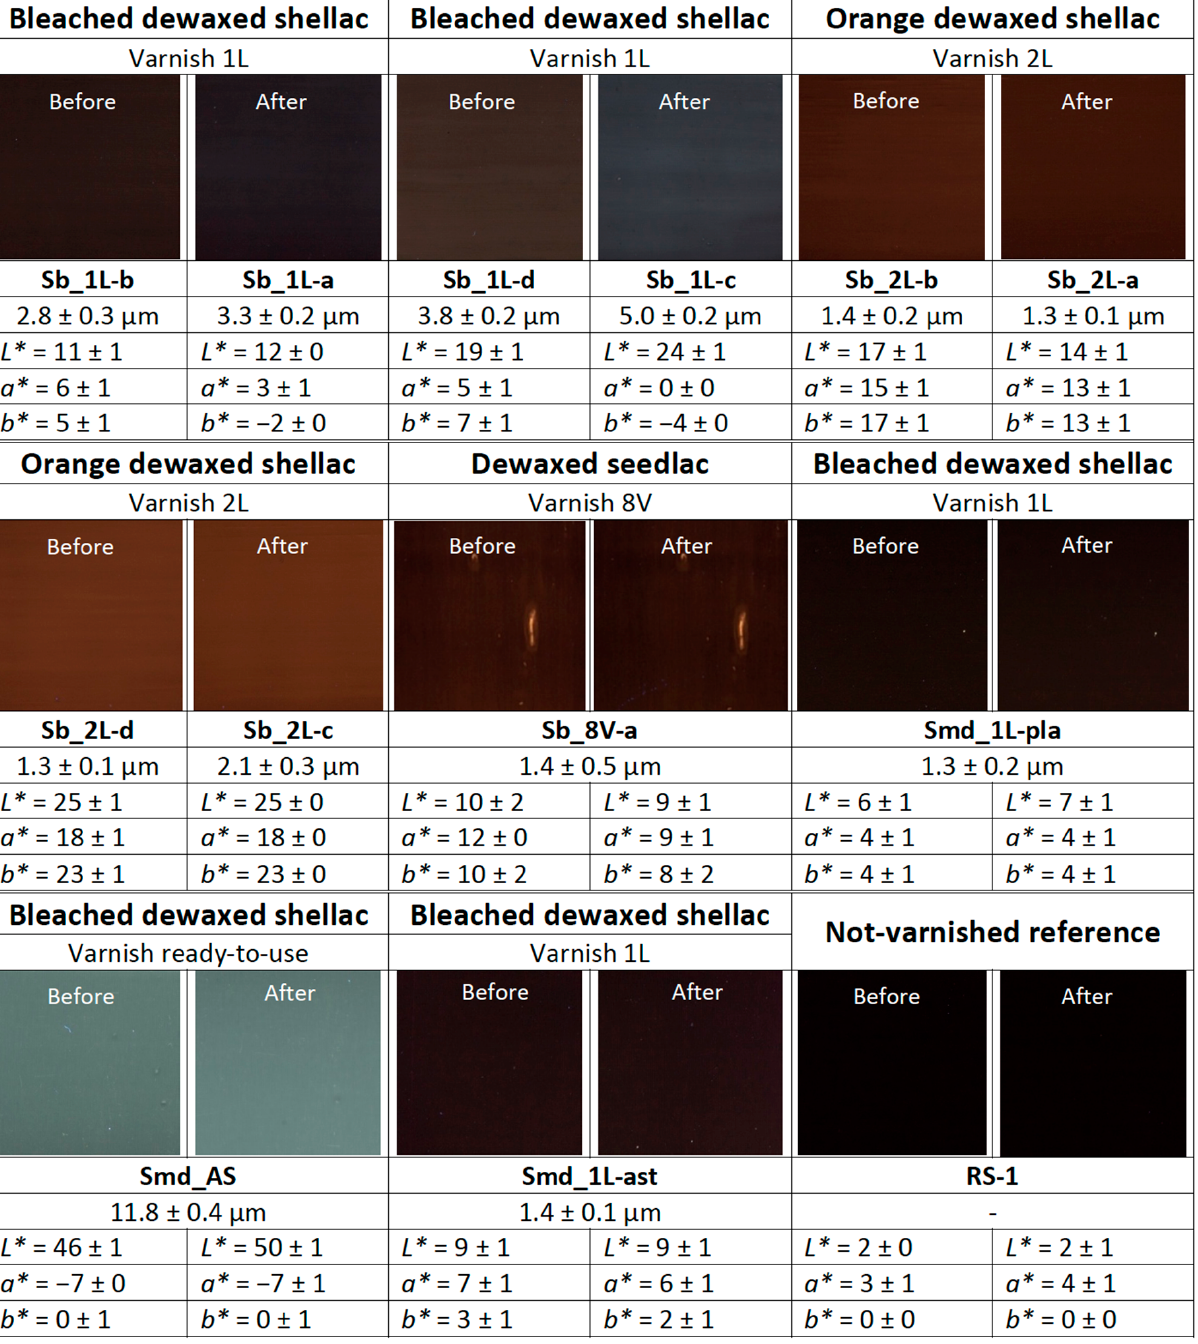
Figure 4. Results of the UV imaging and the colorimetric analysis performed on samples before and after artificial ageing.